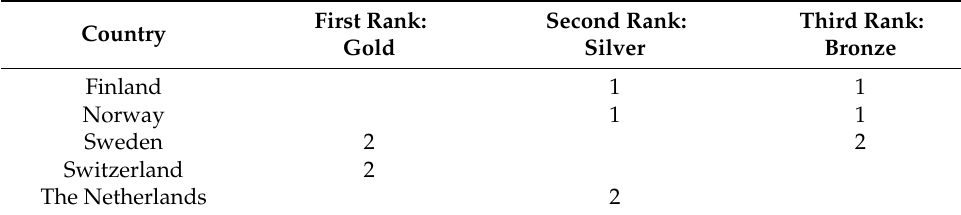
Table 3. Ranking European medalists in 2016, from [33]. Country